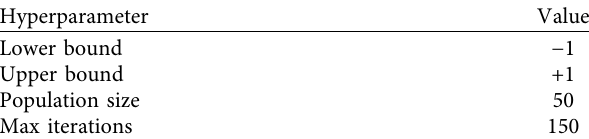
Figure 5: Experimental vs. forecasted compressive strengths for ANN-BAT-1L (14) model for training data.